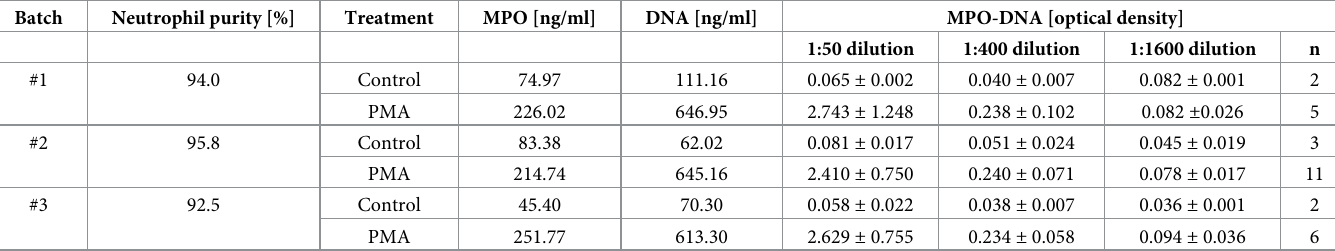
Table 1. MPO, DNA and MPO-DNA content of in vitro generated NET samples.